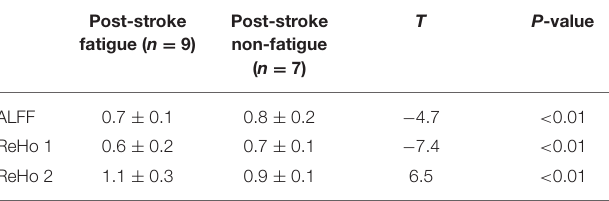
ReHo 1: Brain regions with reduced ReHo value, corresponding to the blue area in Figure 4 . ReHo 2: Brain regions with increased ReHo value, corresponding to the orange area in Figure 4